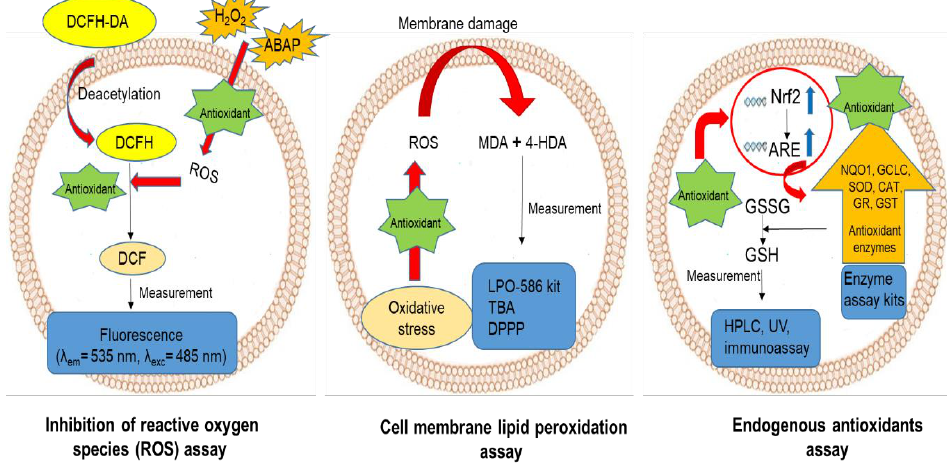
Figure 3. An illustration of some major intracellular antioxidant